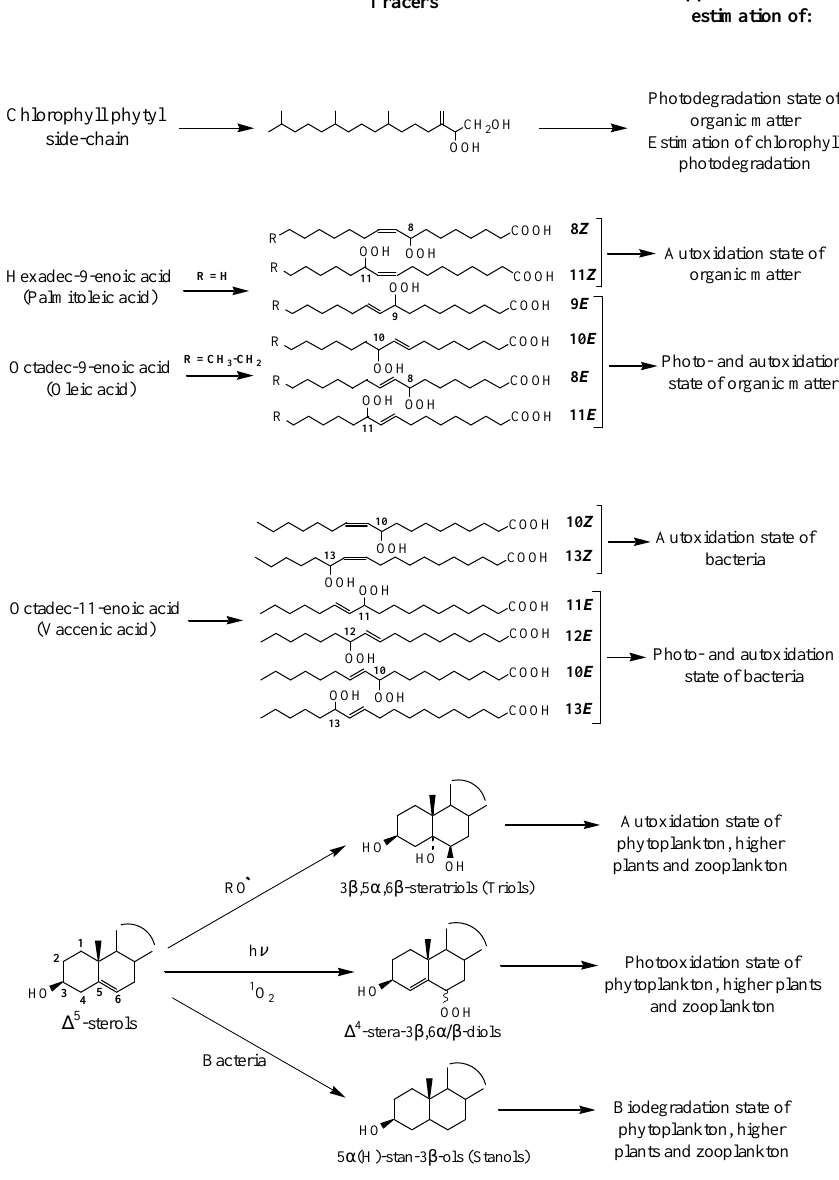
Fig. 2. Formulae and potential applications of the different lipid tracers of degradation processes employed in the present work. 1 Quantified after NaBH 4 -reduction to the corresponding alcohols and subsequent